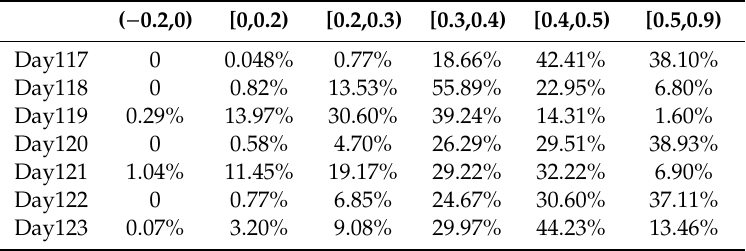
Table 2. The proportion of users with di ff erent rates of growth during